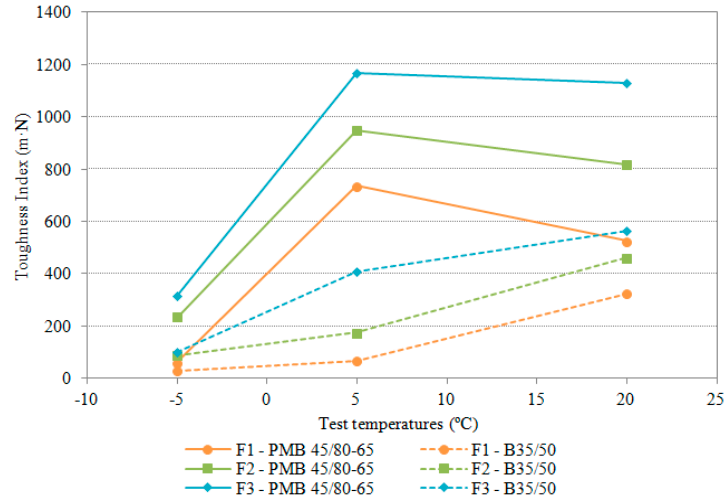
Figure 6. Toughness index versus temperature.